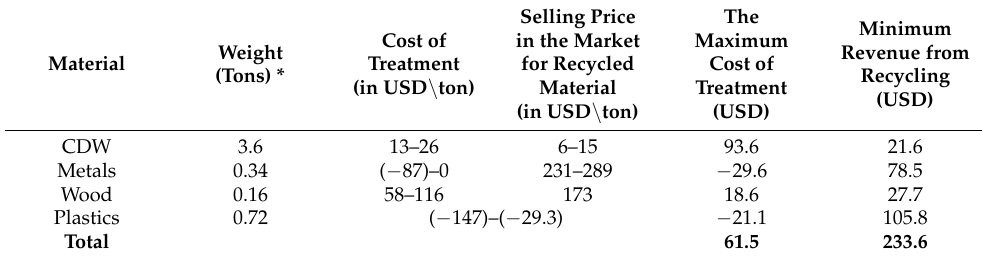
Table 3. Economic analysis for site #3.